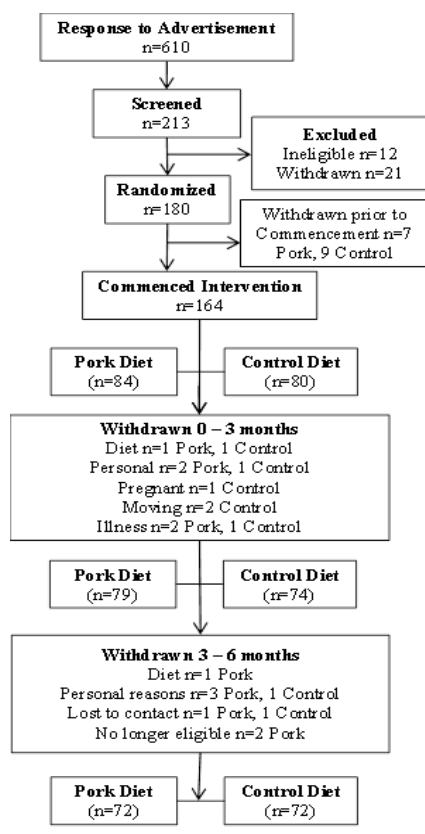
Figure 1. Consort